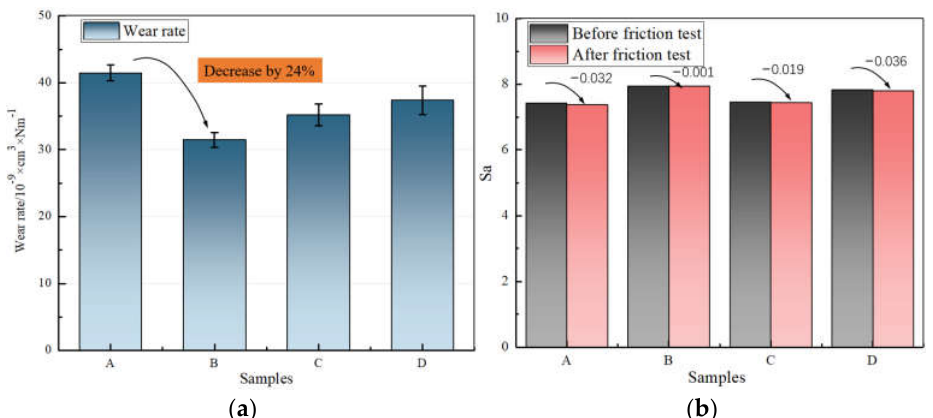
Figure 5. A comparison of the wear rate and Sa of the metal surface. ( a ) Wear rate and ( b ) comparison of Sa (A: 0 phr MoDTC; B: 3 phr MoDTC; C: 6 phr MoDTC; D: 9 phr MoDTC).